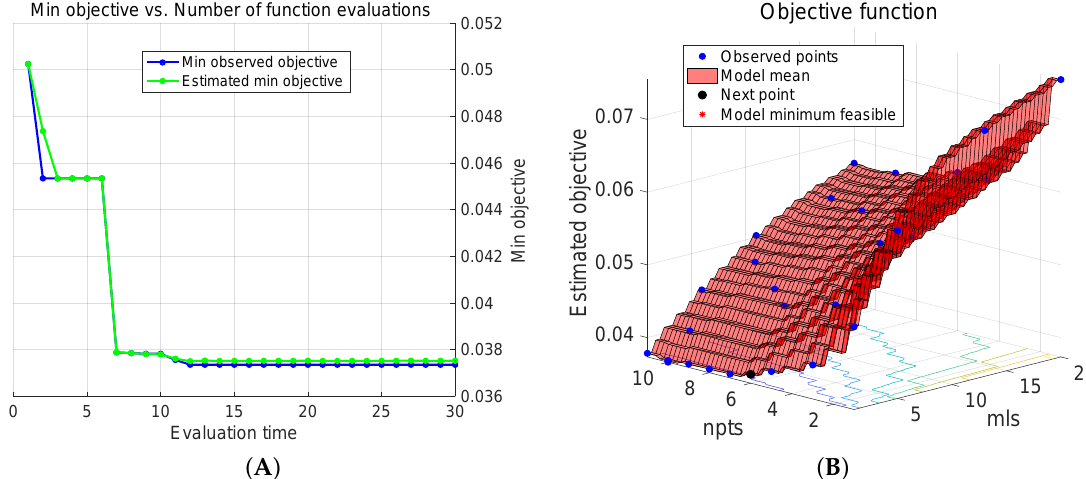
Figure 7. ( A ) Minimum objectives over evaluation time by using full multispectral band features; ( B ) estimated fitness function values over the combinations of npts and mls by using full multispectral band